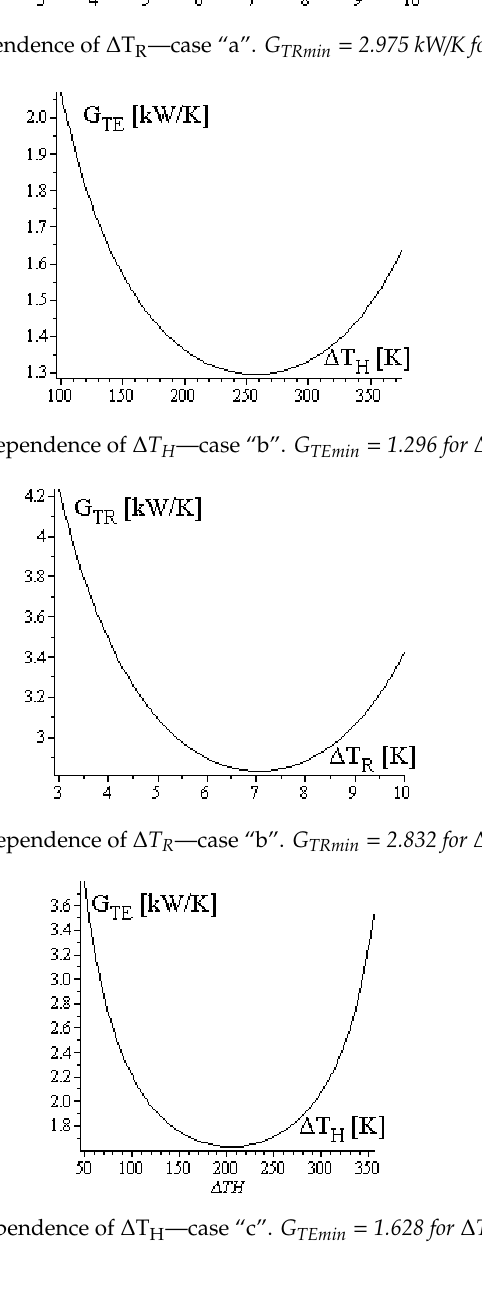
Figure 19. G TR dependence of Δ T R —case “c”. G TRmin = 2.574 for Δ T R = 7.77 K. Figure 20. G TE dependence of Δ T H —case “d”. G TEmin = 1.295 for Δ T H = 257 K. Figure 21. G TR dependence of Δ T R —case “d”. G TRmin = 2.574 for Δ T R = 7.77 K. All Equations for thermal conductance inventory exhibit minimum values corresponding to g H = 0.5 and g R = 0.5. This quality is compatible with minimum investment costs (minimum CAPEX) regarding the heat exchangers of the trigeneration subsystems.